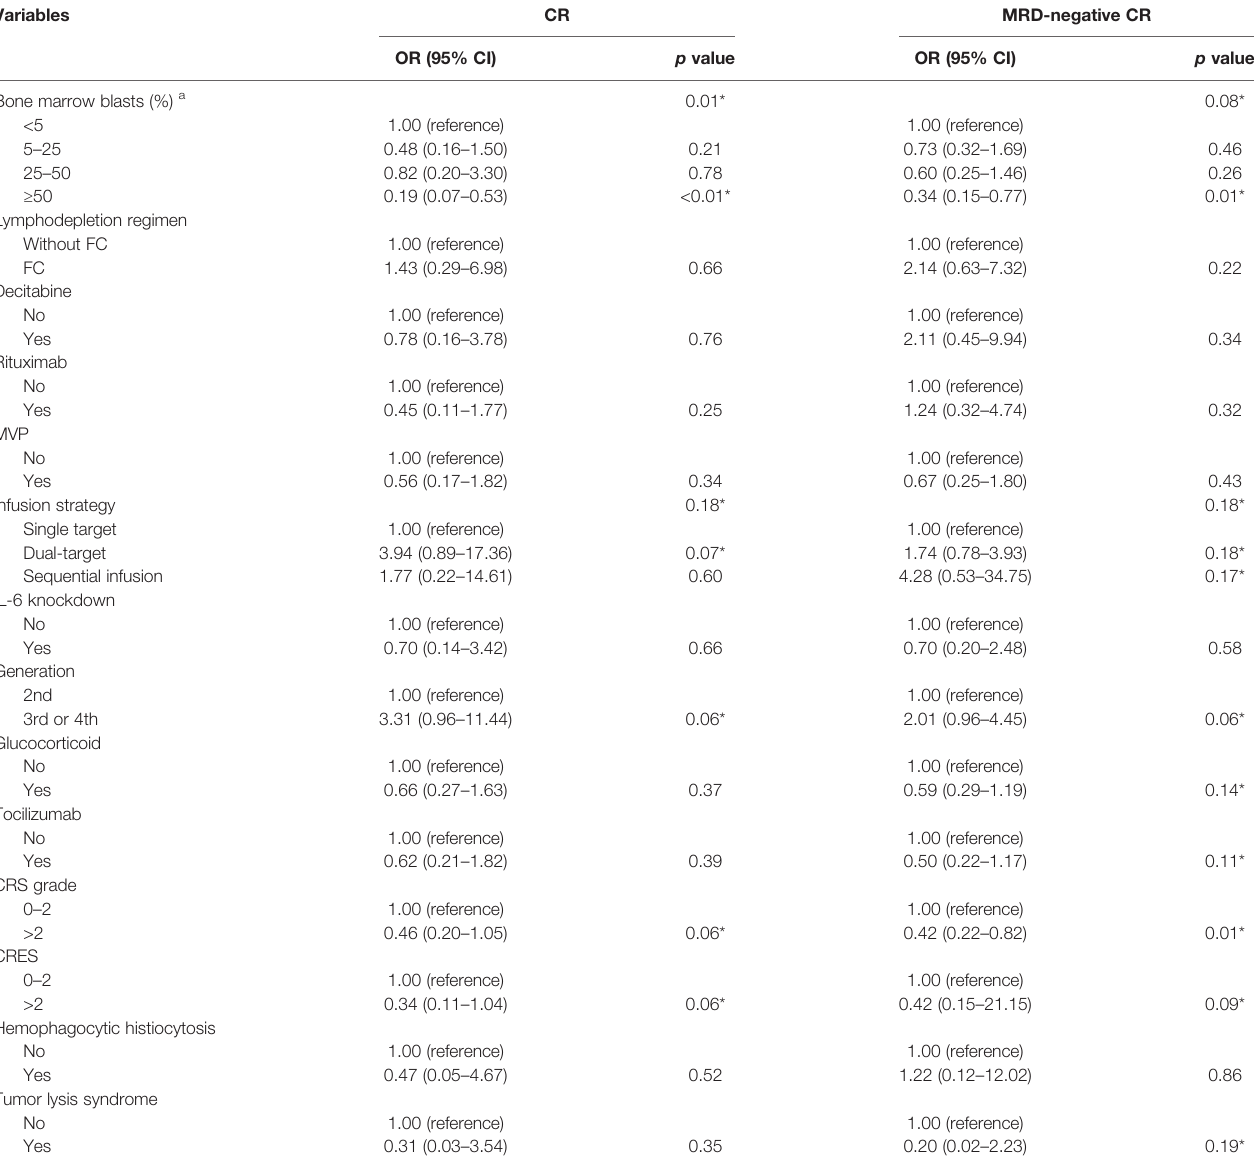
TABLE 3 | Univariate logistic regression analyses of the baseline information of CAR-T therapy and CAR-T cells associated with CR and MRD-negative CR.